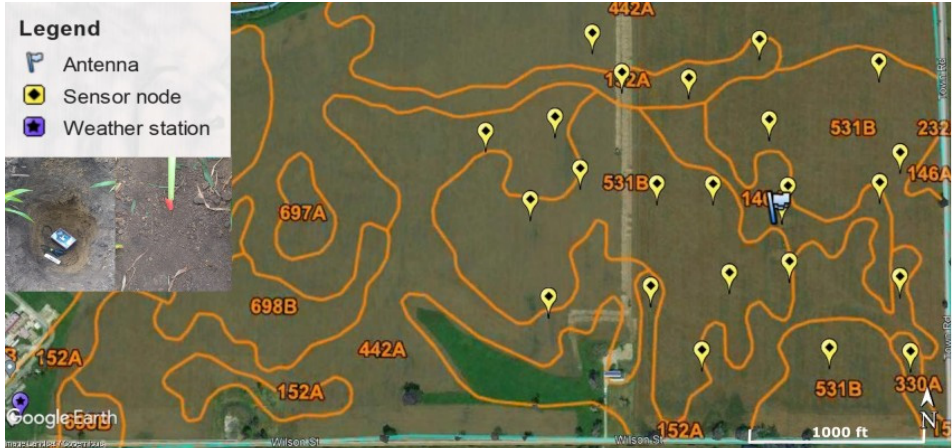
Figure 2. Sensor node locations (yellow pins), base station location (flag), weather station (purple pin), and soil types (orange lines and numbers denote USDA soil type assessment). Inserts show a sensor node deployed in the soil.